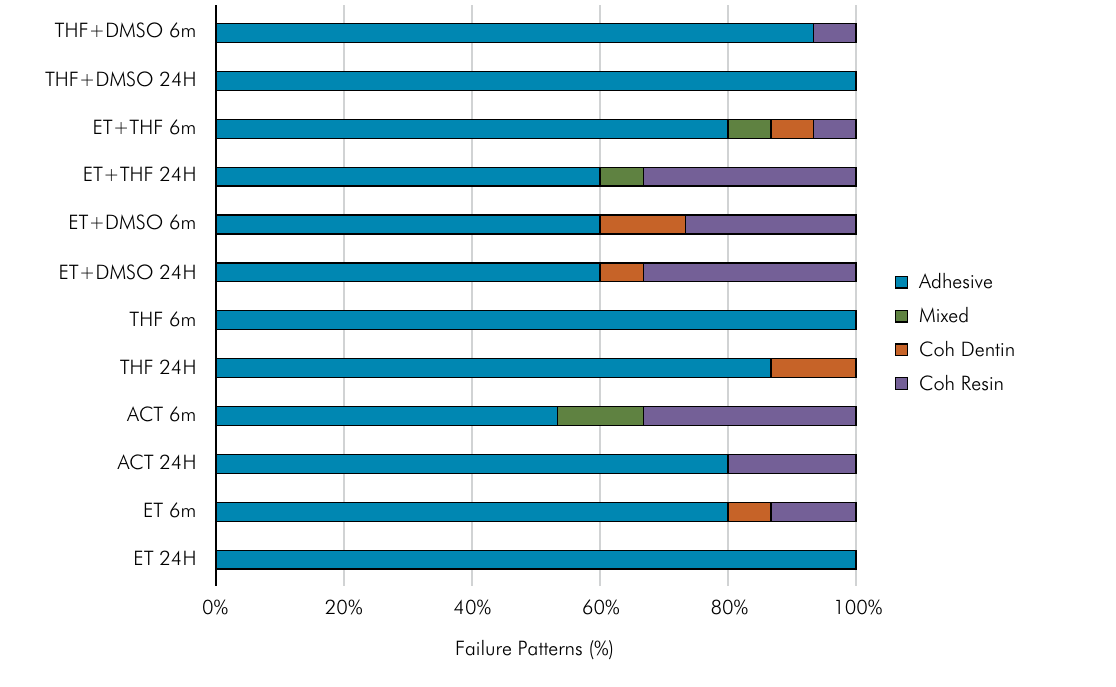
Figure 3. Outcomes of failure pattern analysis.